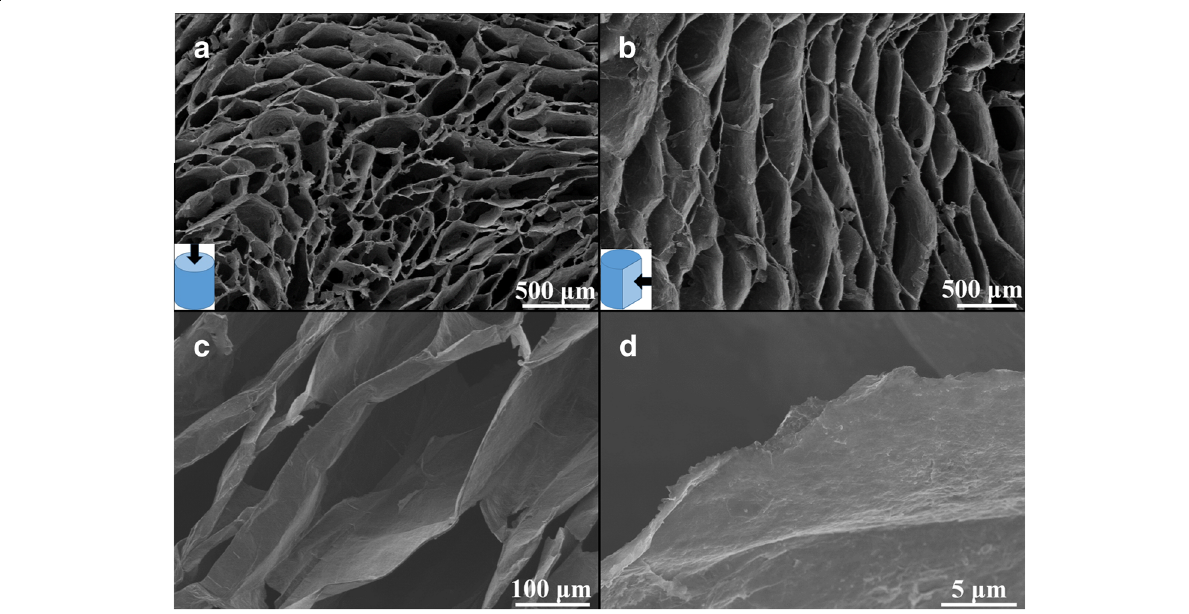
Fig. 2 SEM images of a cross-section and b vertical-section of the superelastic graphene aerogel. c , d Cross-section view of superelastic graphene aerogel at different